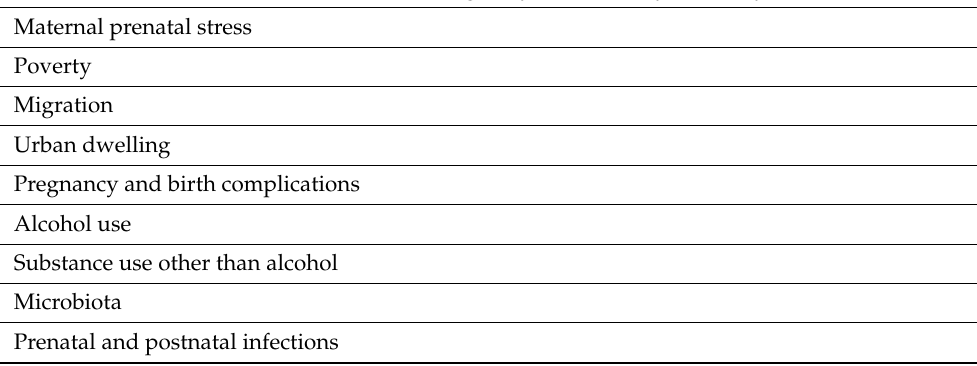
Table 1. Environmental factors interacting epigenetically with the genome in the pathogenesis of psychiatric